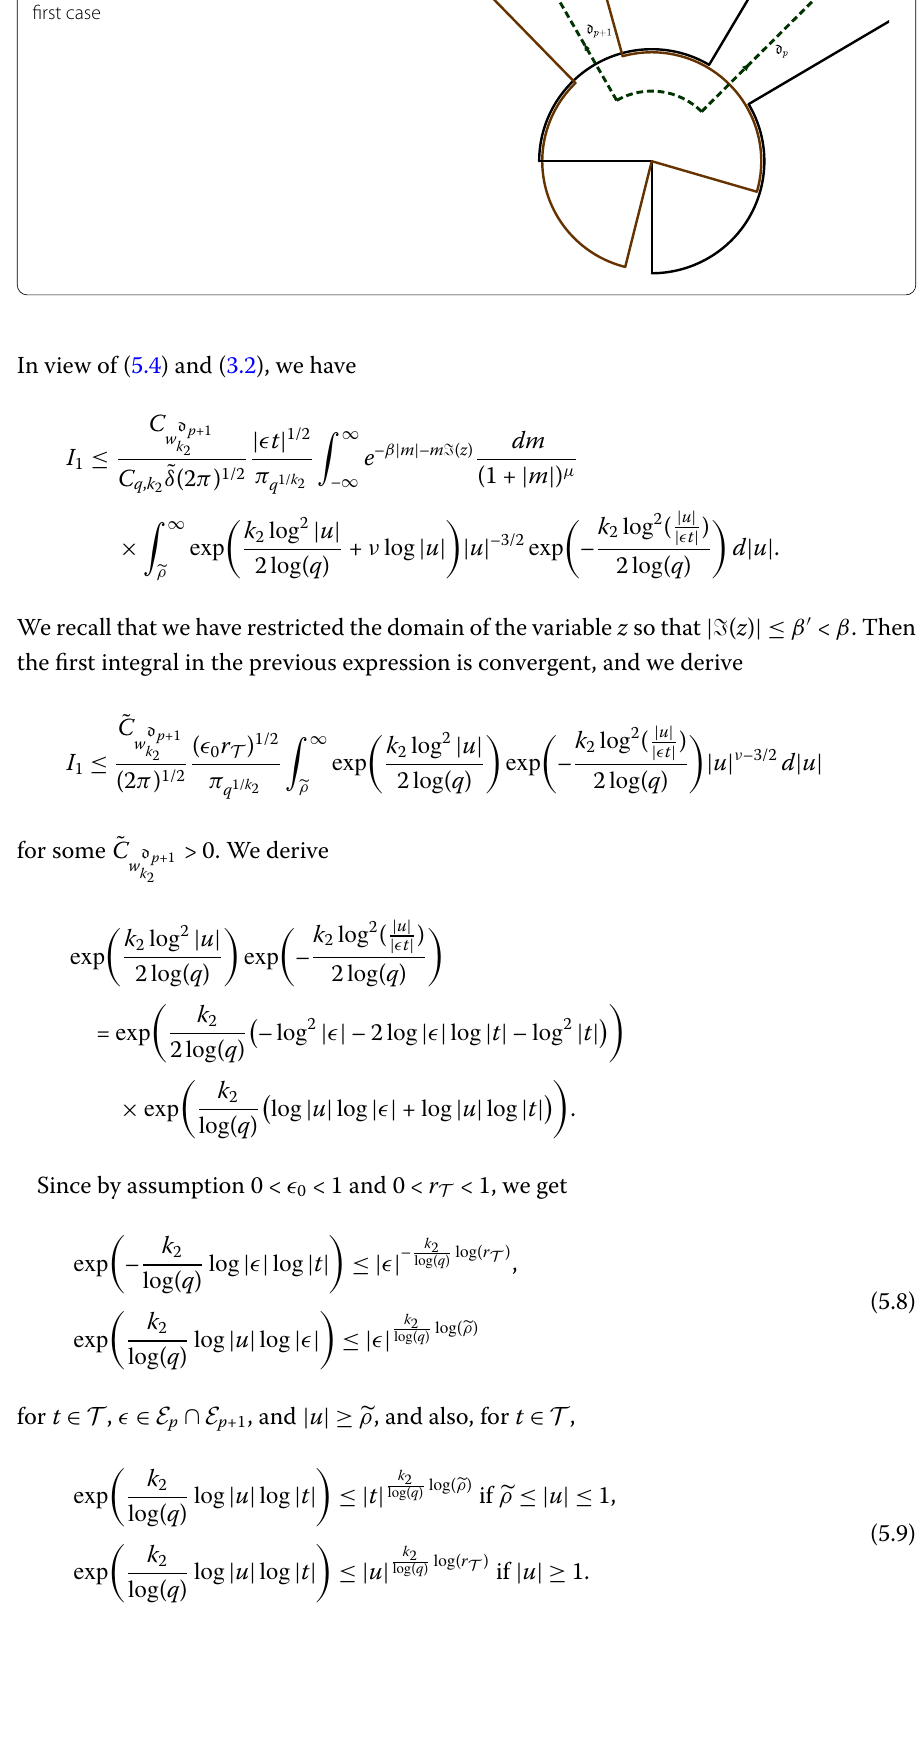
Figure 2 Deformation of the path of integration, first